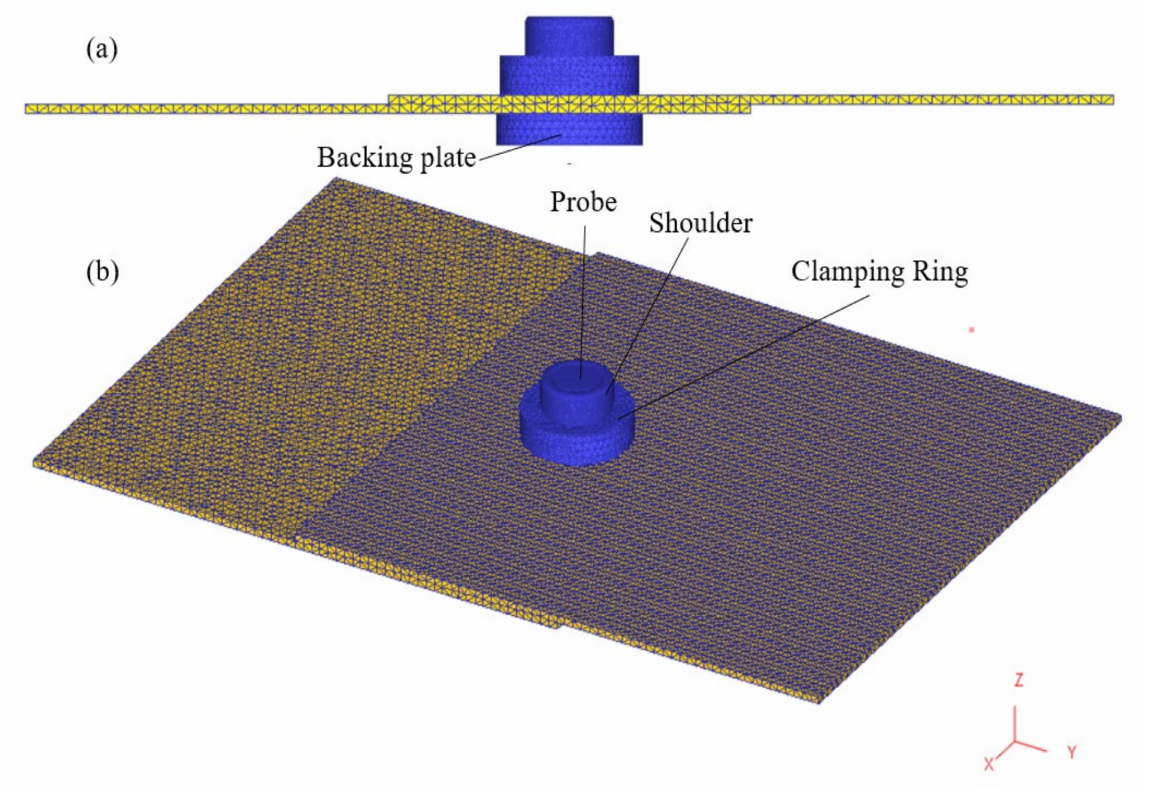
Figure 5. Meshed model of the refill FSSW process setup. ( a ) Side view; ( b ) isometric view.